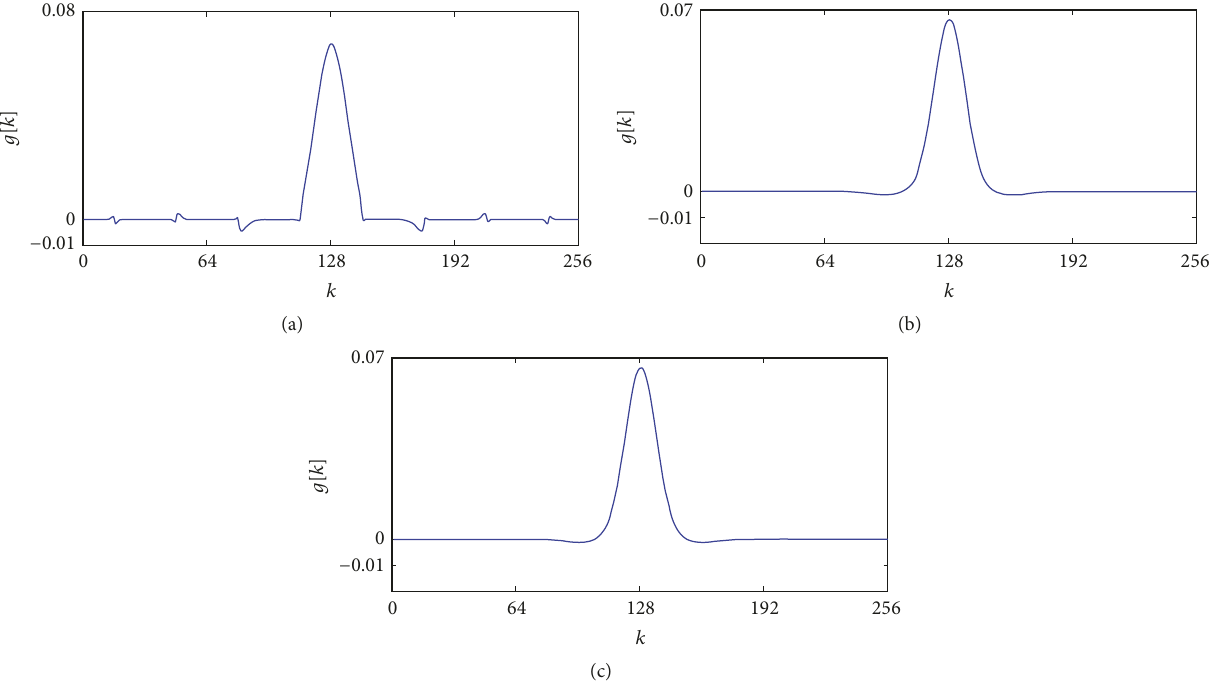
Figure 3: Analysis windows 𝑔[𝑘] in the oversampling case ( Δ𝑀 = 32 , Δ𝜔 = 8 , 𝛽 = 4 ) obtained by the proposed method [9, 10].